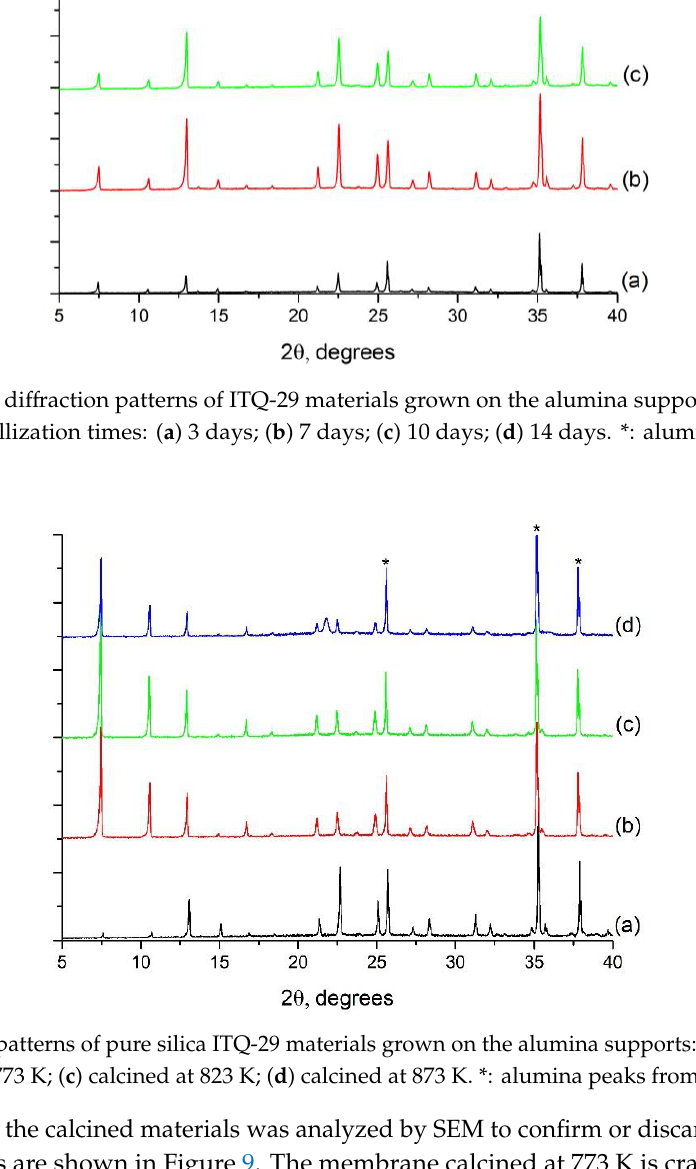
( c ) Figure 9. Top view SEM images of ITQ-29 materials grown on the alumina supports after calcination at: ( a ) 773 K; ( b ) 823 K; ( c ) 873 K. The aluminum content on the zeolite has an impact on its polarity, and it is crucial to obtain pure silica membranes to avoid olefins oligomerization during the olefin/paraffin separation, and take advantage of its high hydrophobicity during water/bioalcohols separation. For that reason, energy dispersive X-ray spectroscopy (EDX) analyses were performed on the calcined pure silica ITQ-29 membrane to study if aluminum incorporation into the zeolitic framework took place in some extent, and also to analyze the zeolite intrusion into the porous support. The selected material was prepared after 7 days of secondary growth, and calcined for 6 h at 773 K. Atomic percentages of silicon and aluminum were analyzed along the membrane, and the results are shown in Figure 10. It was found that, within the detection limits, the aluminum was not incorporated into the zeolite layer. So, the membrane consisted of pure silica ITQ-29 zeolite and the aluminum from the support was not dissolved during the synthesis and incorporated into the zeolite framework; and it did not migrate 30 µm